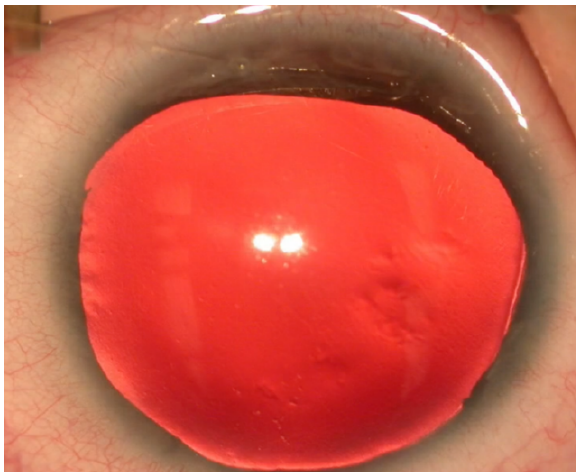
Figure 1: Anterior segment photograph of case 1, showing almost complete lack of iris tissue